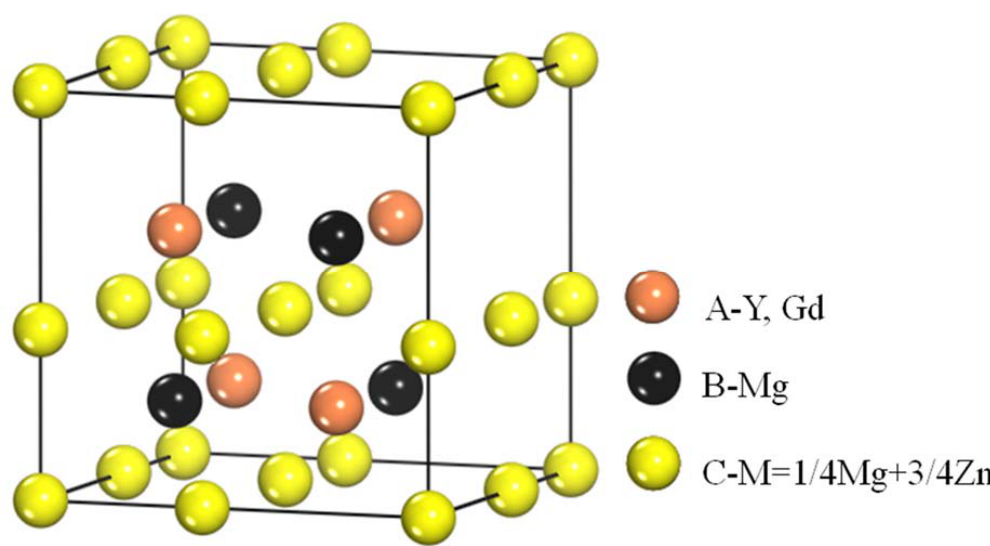
Figure 14. The crystal structure of the W phase in the Mg-Zn-Y(Gd) system, the atomic